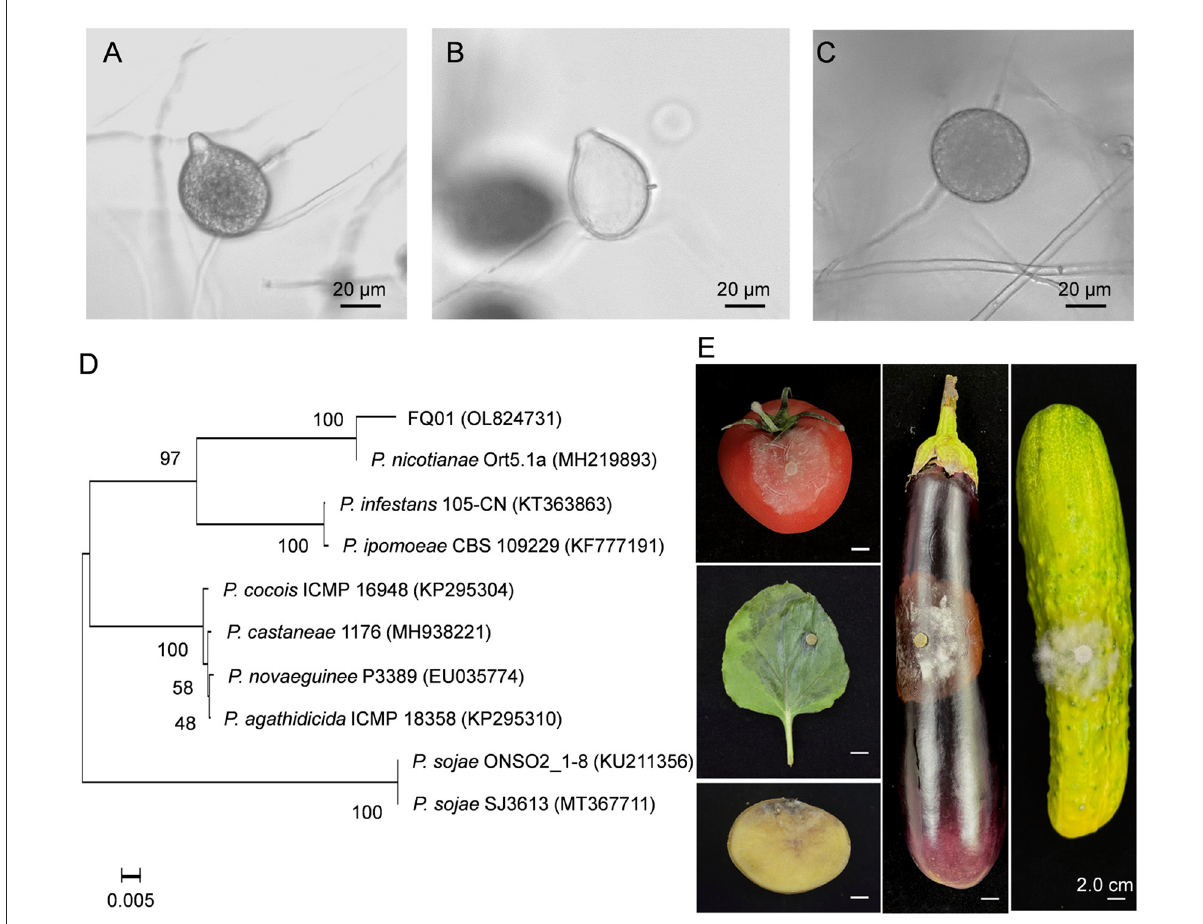
FIGURE1 Identification of the pathogen FQ01. (A) Sporangial morphology before the release of zoospores. (B) Sporangial shell after the release of zoospores. (C) Chlamydospore morphology. (D) Phylogenetic tree of the pathogen FQ01 and other Phytophthora strains based on a neighbor-joining analysis of ITS sequence. (E) Symptoms of plant diseases caused by P. nicotianae FQ01